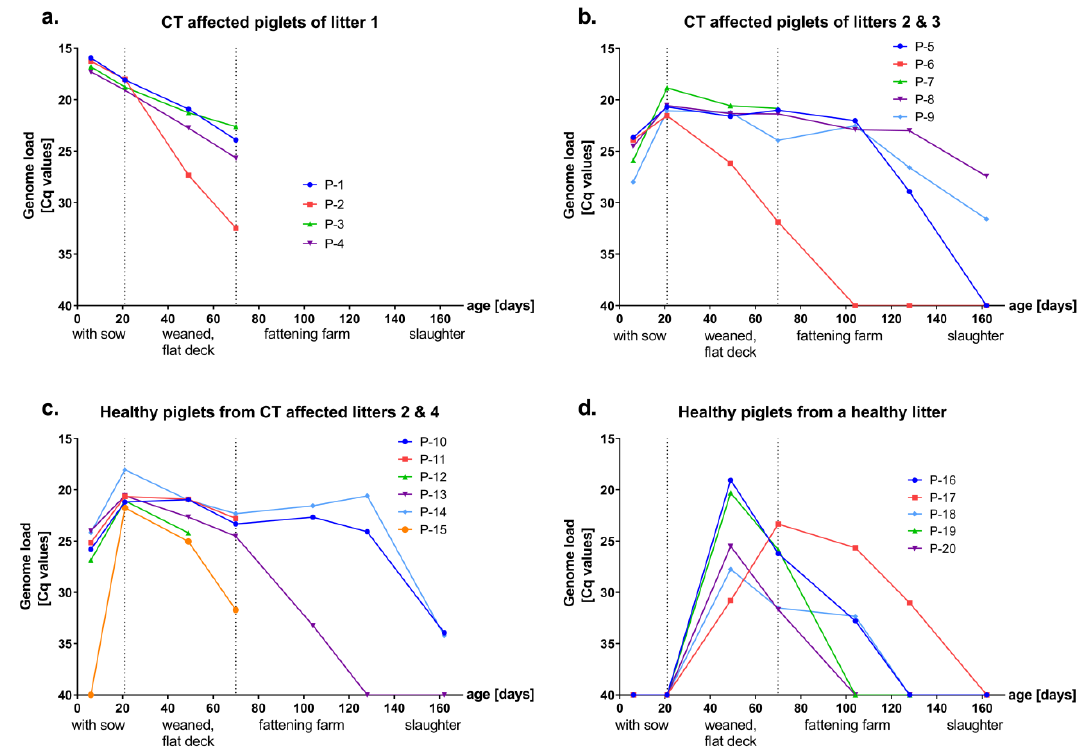
Figure 1. Atypical porcine pestivirus (APPV) genome titers of piglets from congenital tremor (CT) a ff ected litters ( a–c ) and piglets from a healthy litter ( d ). Genome loads of 20 piglets were investigated by real-time RT-PCR. Cq values of serum samples ( y axis), the age of piglets and holding conditions ( x axis) are indicated. Vertical dashed lines indicate the changes in the holding conditions. Piglets from CT a ff ected litter 1 ( a ) were cross-fostered immediately after birth to a pluriparous sow with a healthy litter. Piglets from CT a ff ected litters 2, 3 and 4 are grouped into two panels ( b,c ) by the occurrence of CT.